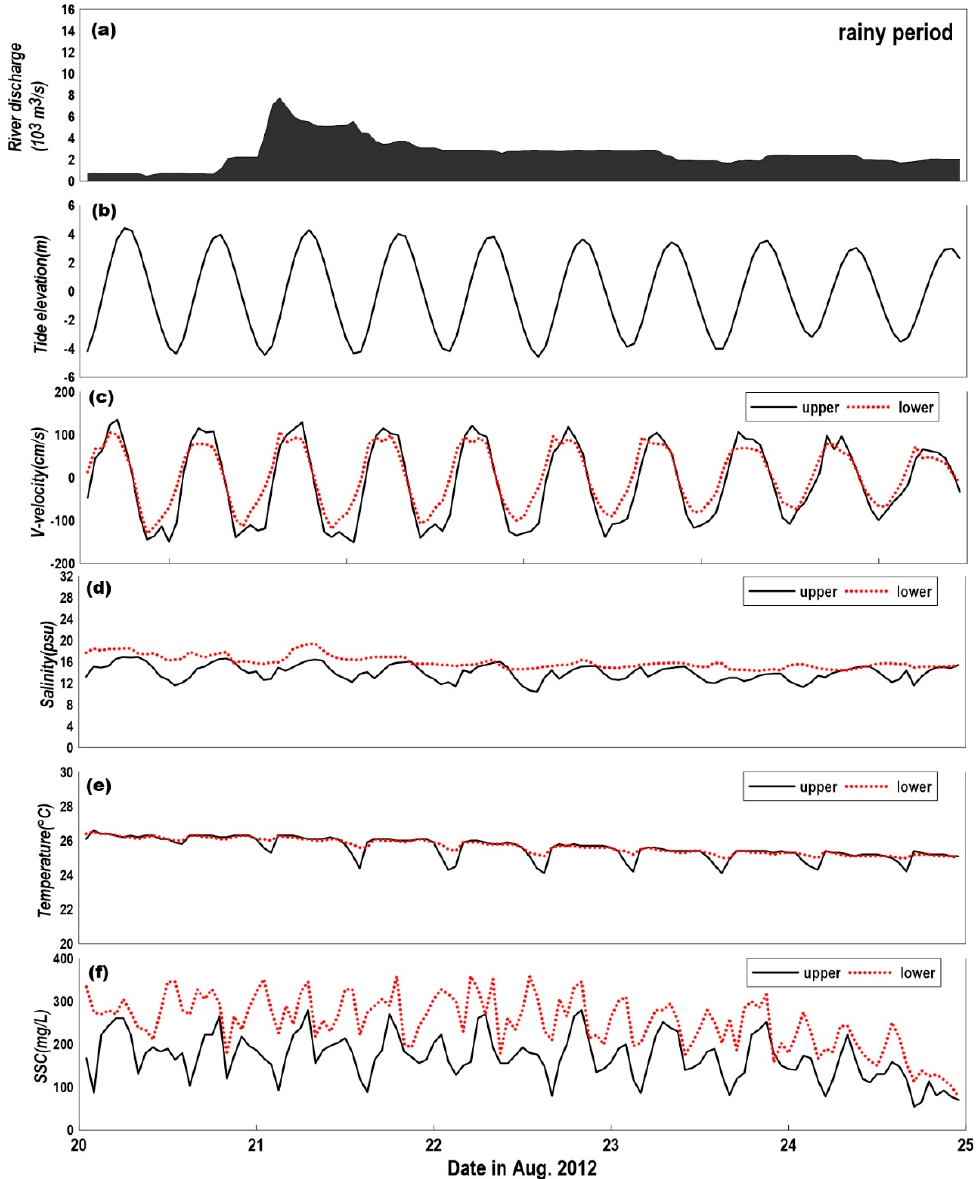
Figure 4. Time series of the observed data during the rainy period: ( a ) freshwater discharge from Han River, ( b ) tide elevation of Incheon station, ( c ) horizontal flow velocity ( + : north, − : south), ( d ) salinity, ( e ) temperature, and ( f ) SSC.